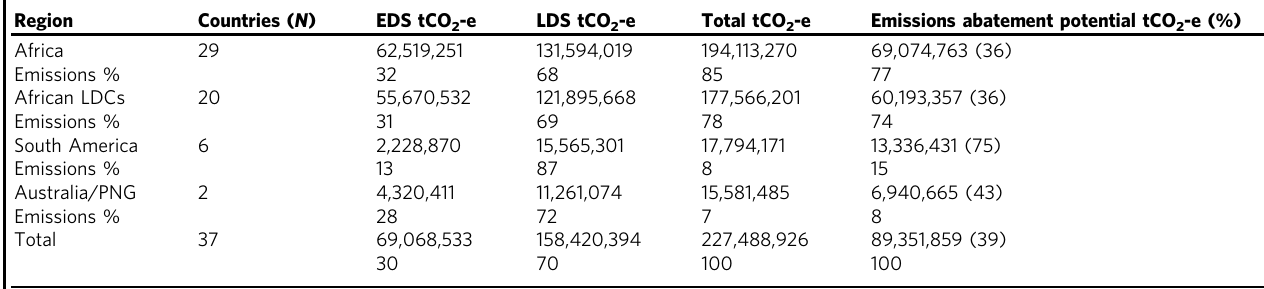
Table 2 Total emissions in the early dry season (EDS) and late dry season (LDS) and abatement potential for the 37